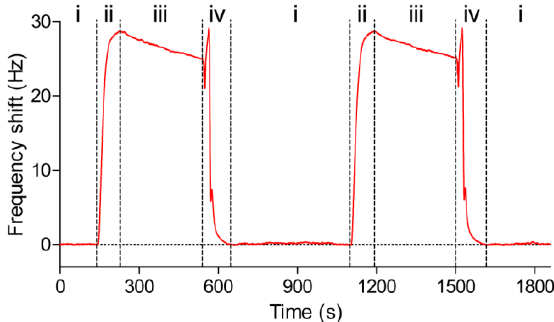
Figure 6. QCM analysis of the binding of myoglobin with anti-myoglobin 7005 antibody immobilized on the PDA-coated sensor surface. Frequency shift was recorded during the association (84 s) and dissociation (300 s) phases of the interaction between myoglobin and anti-myoglobin 7005, as well as the subsequent desorption of the remaining bound myoglobin by an injection of the 10 mM glycine pH 1.5. (i) Base line; (ii) Association; (iii) Dissociation; (iv) Regeneration.